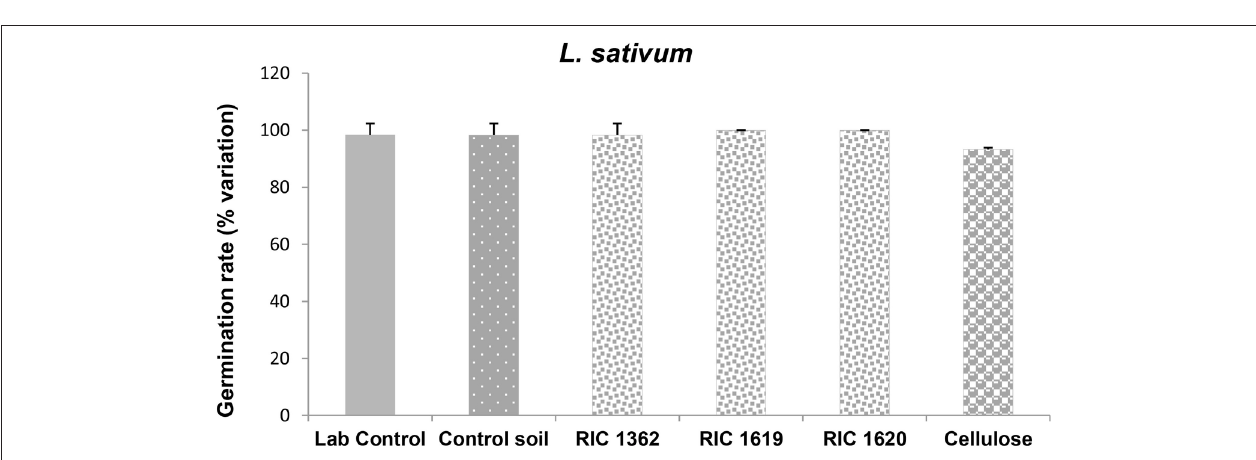
FIGURE 4 | Germination of L. sativum after exposure to the soil samples. Data are expressed as % variation and represent the mean ± SD of at least five replicates. *Indicates statistically significant differences with respect to lab control values ( p < 0.05 Mann–Whitney U -test). RIC 1362, RIC 1619, RIC 1620, Mater-Bi soils; Cellulose, soil containing cellulose reference